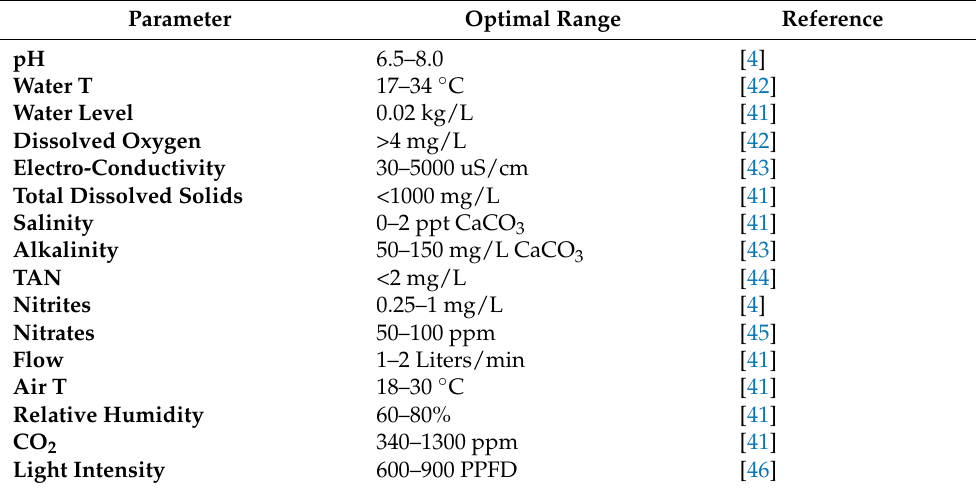
Table 2. The optimal ranges of different aquaponics